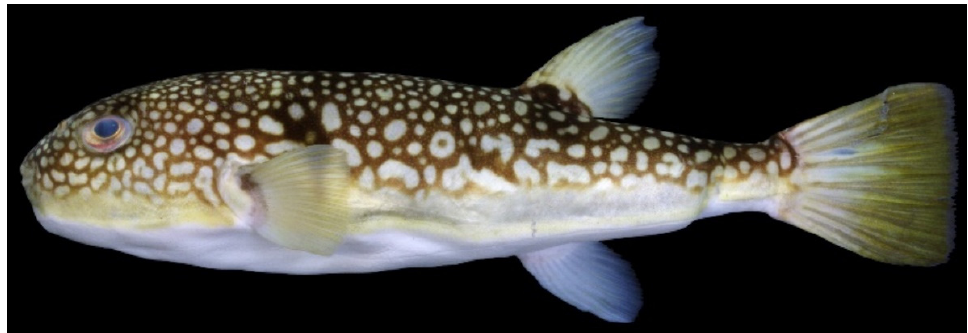
Figure 1. A pufferfish Takifugu flavipterus (KAUM-I. 80923). The photograph was taken by